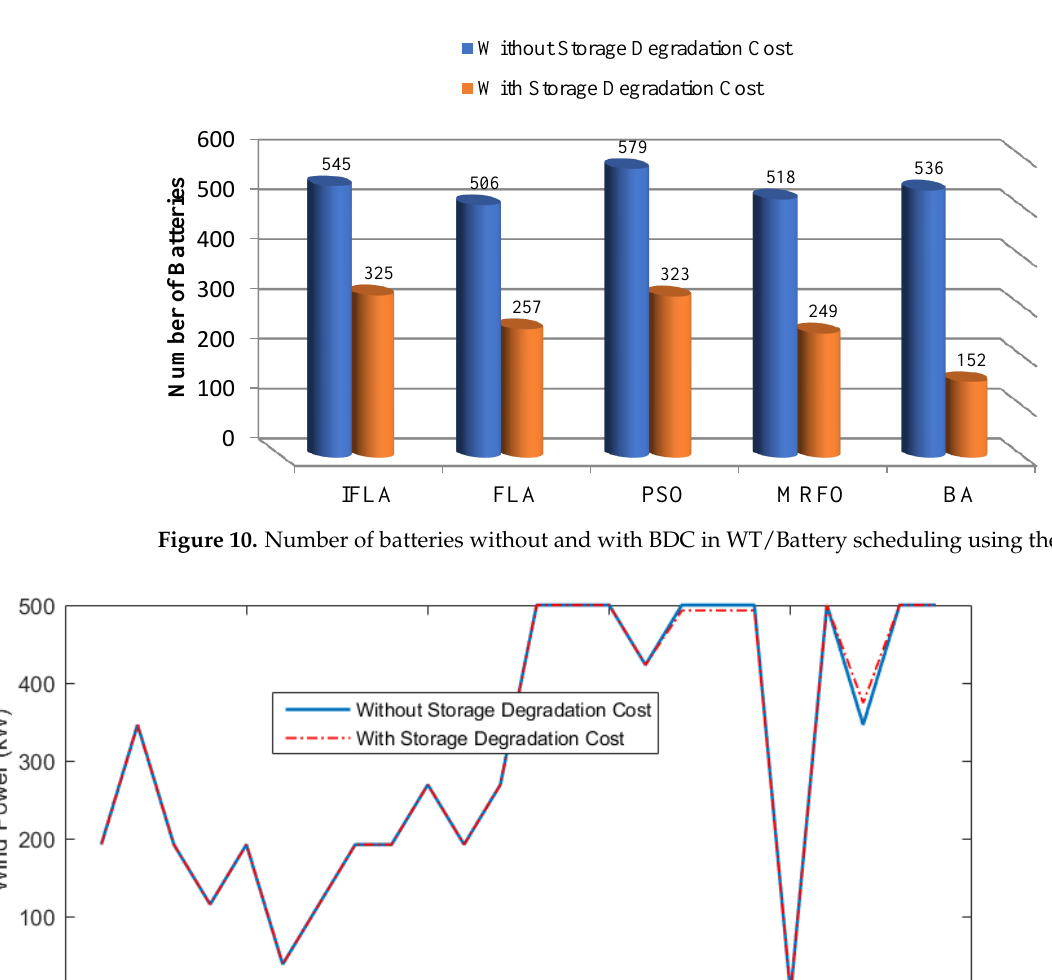
Figure 9. Value of objective function using different algorithms without and with storage degrada- tion cost.